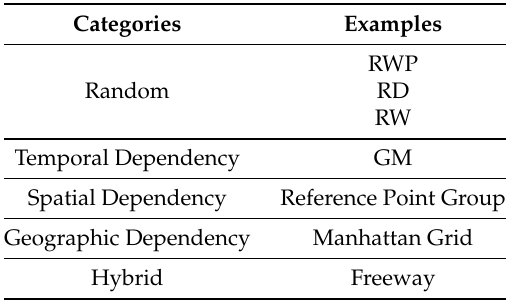
Table 1. Categories of mobility models in wireless